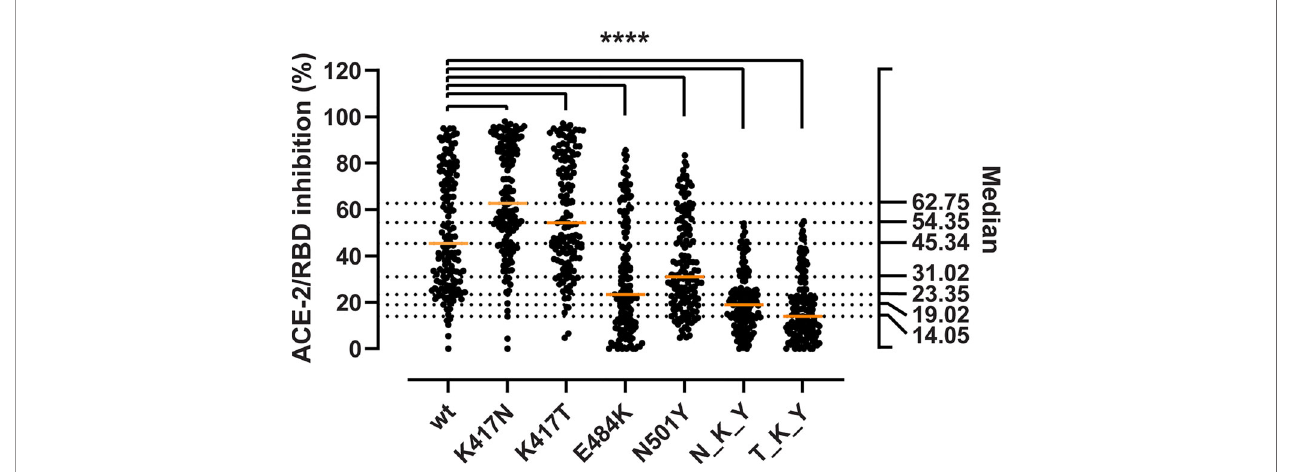
FIGURE 3 | Inhibitory potency of COVID-19 convalescent patient sera against RBD variants. Antibody-mediated inhibition of serum from recovered COVID-19 patients ( n = 150) against RBD wt, and the RBD-de fi ning mutations from the B.1.351 and P.1 strains. Statistical comparisons between groups were performed using the Friedman test with Dunn ’ s multiple comparisons. Orange lines represent medians. The signi fi cance value applies to each of the pairwise comparisons between the wt and each of the single and combined mutations. ****, p <